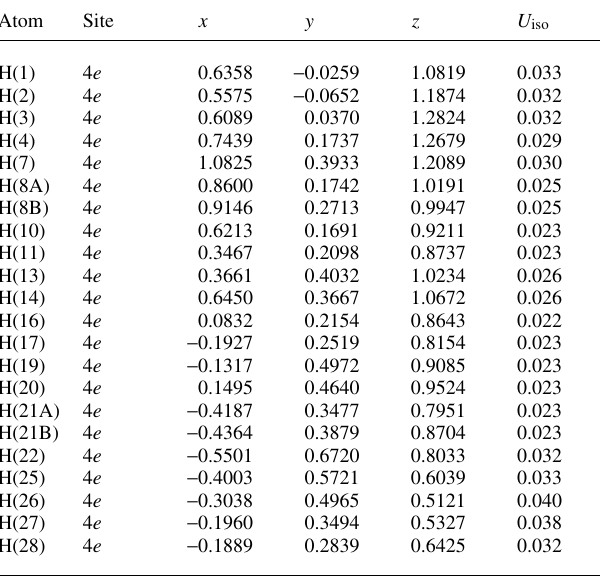
Table 2. Atomic coordinates and displacement parameters (in Å 2 )